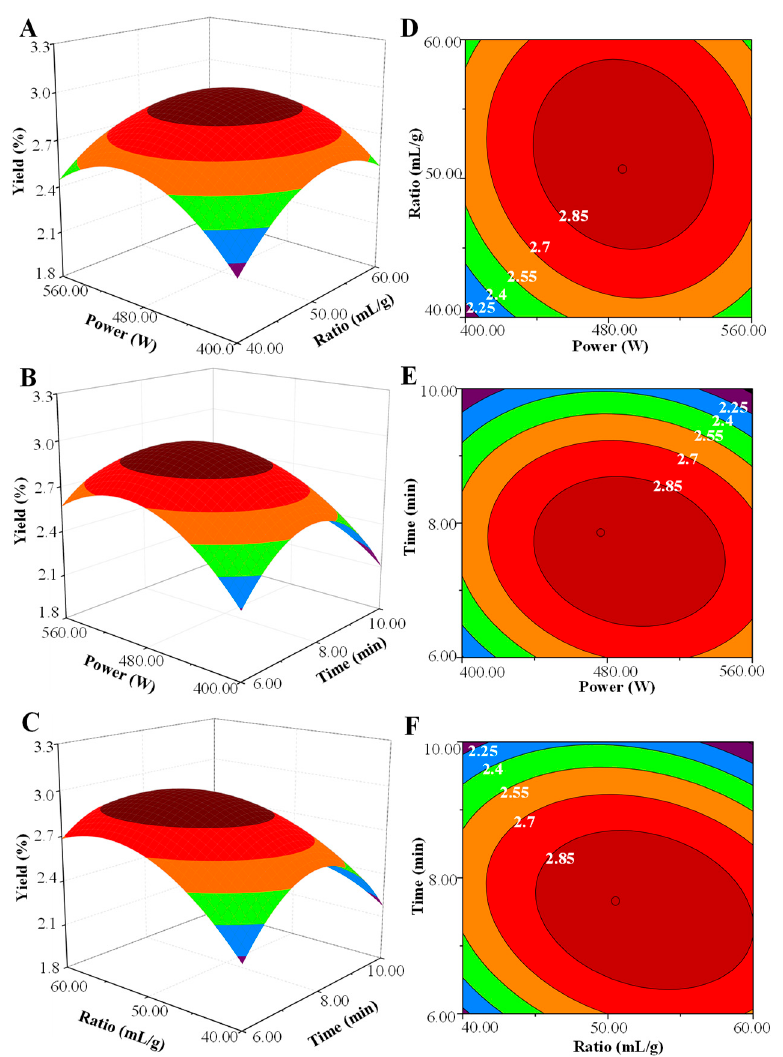
Figure 2. Three-dimensional response surface ( left ) and two-dimensional contour ( right ) plots of microwave-assisted extraction. ( A , D ) microwave power and ratio of water to raw material; ( B , E ) microwave power and microwave extraction time; ( C , F ) ratio of water to raw material and microwave extraction time.